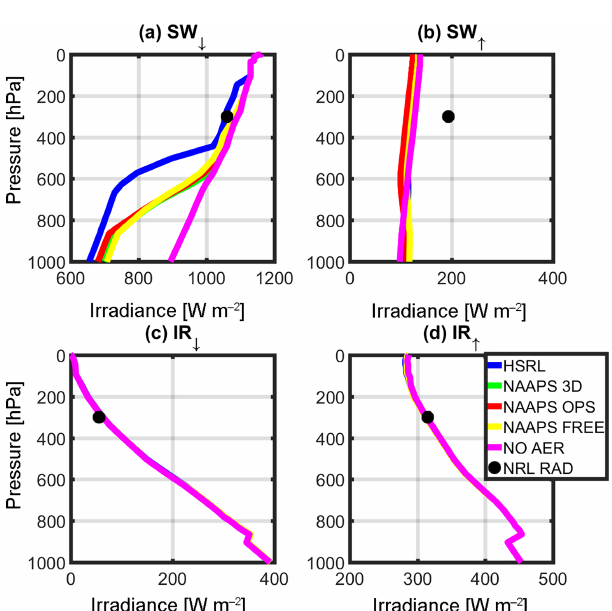
Figure 2. (a) NAAPS and (b) HSRL aerosol vertical distribution (AODs) for the 19 August case study, with corresponding aerosol speciation.